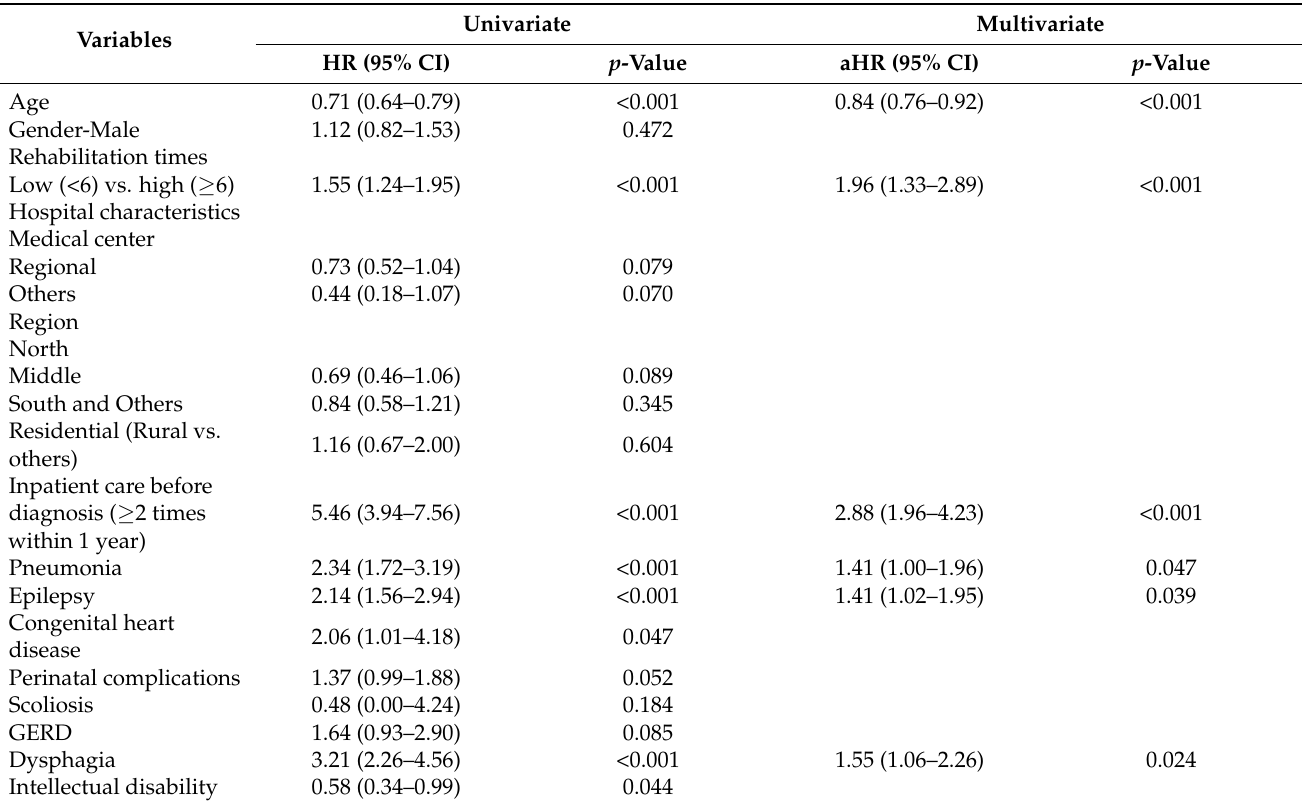
Table 2. Cox regression analysis for moderate to severe CP children with 3-year survival, n =